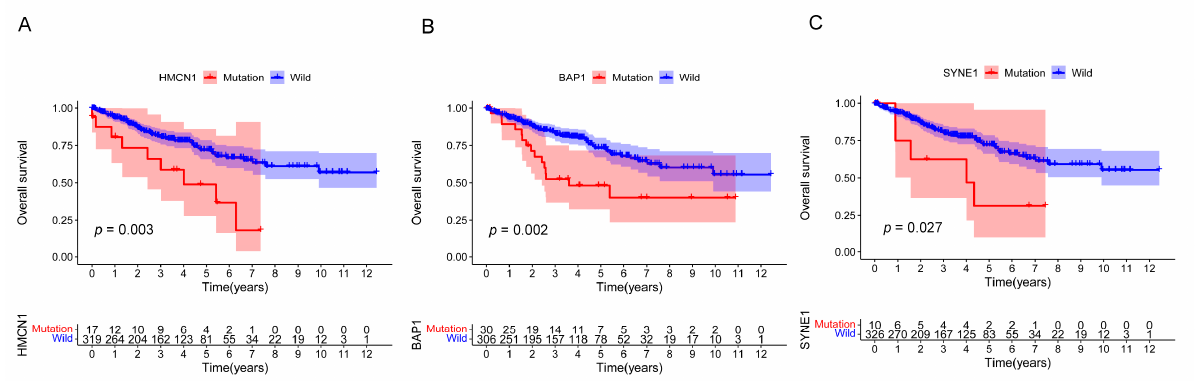
Figure 3. TMB-related gene mutations. ( A ) Venn diagram figures out 12 frequently mutated genes included in both two cohorts. ( B ) Boxplot reveals the correlation of gene mutation and TMB. *: p < 0.05; **: p < 0.01; ***: p < 0.001; ns: p > 0.05.